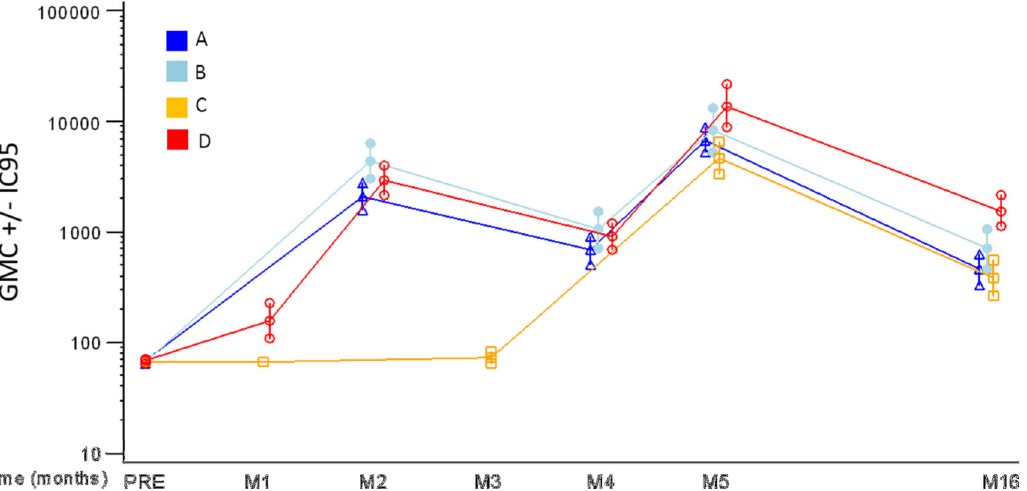
Fig 9. Kinetics of Humoral immune responses against the F4 fusion protein. Anti-F4 IgG antibody concentrations measured by ELISA expressed as geometric mean concentration (GMC) in mEU/ml across groups A-D. Group A = 2xF4/AS01 E / Ad35-GRIN, B = 2xF4/AS01 B / Ad35-GRIN, C = Ad35-GRIN / 2xF4/AS01 B and D = 3xCo-Ad. M = months.